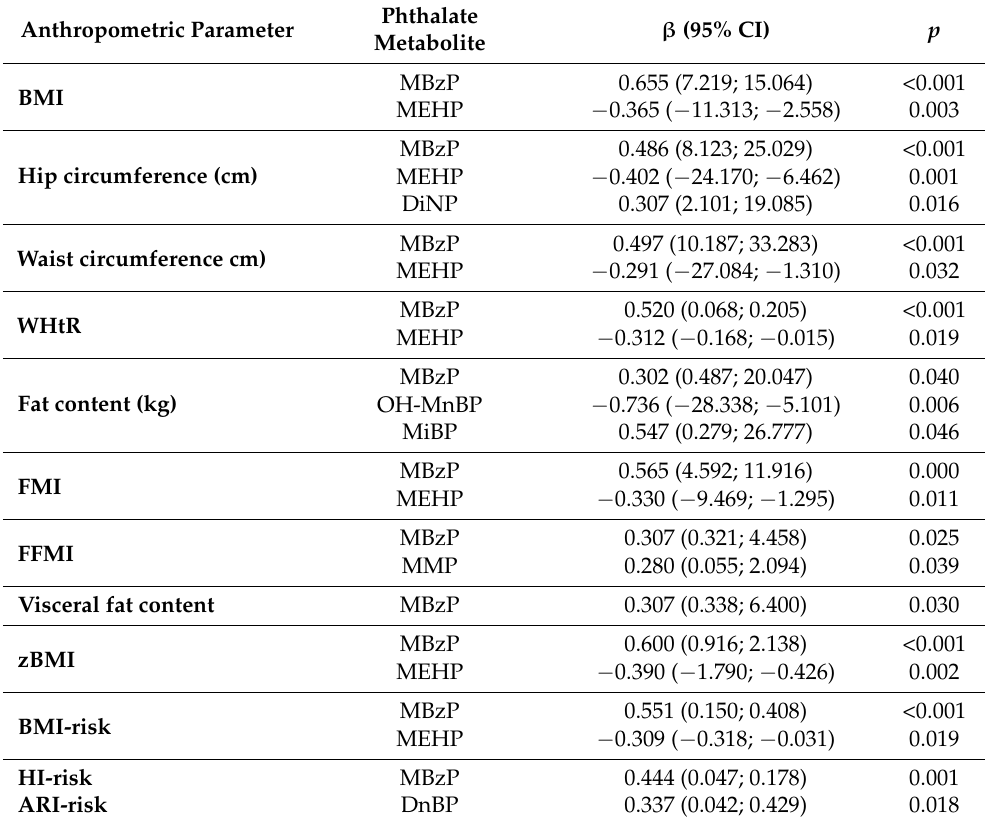
Table 3. Stepwise multiple linear regression analysis of phthalate metabolites effect on the anthropo- metric